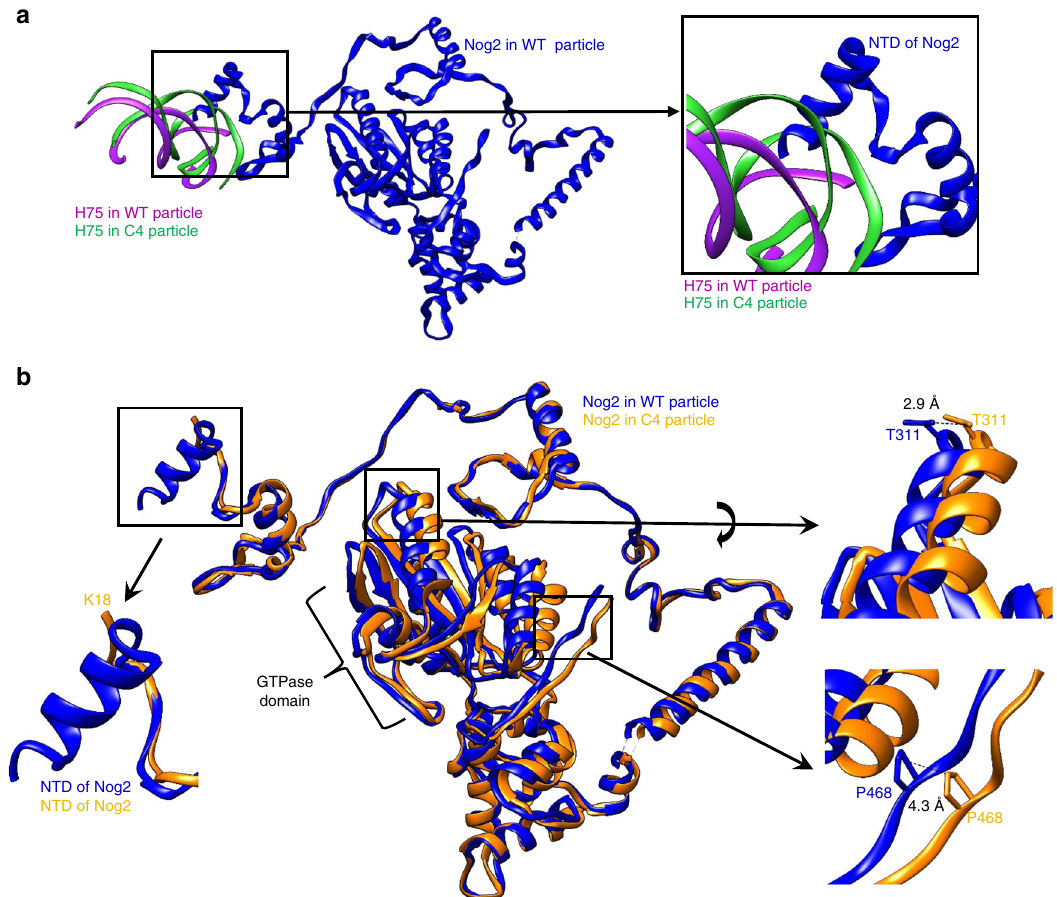
Fig. 6 The conformation of Nog2 is altered in the C4 class of rpf2 Δ 255-344 particles. a The NTD of Nog2 is docked in the groove of H75 near H68 in wild-type particles and may affect the conformations of these helices, or otherwise be affected by them. b Atomic models for Nog2 in wild-type and C4 particles were aligned. The NTD of Nog2 is fl exible and invisible in the C4 class of the rpf2 Δ 255-344 mutant particles. Conformational changes are visible in the GTPase domain of Nog2, where portions of the structure are de fl ected up to 4